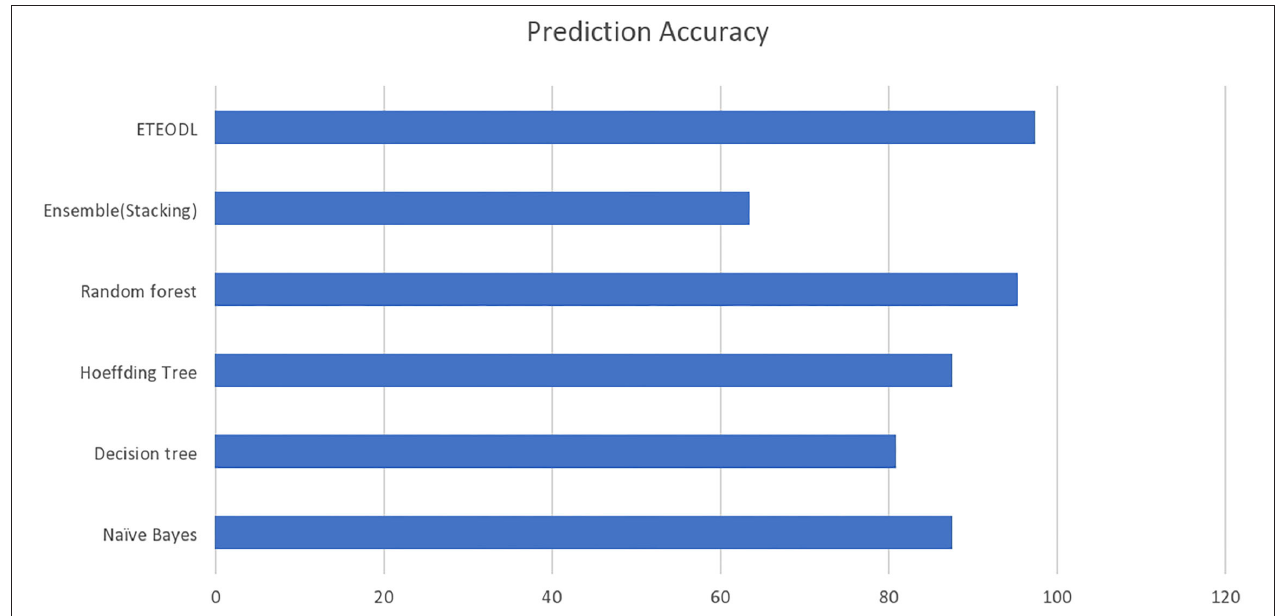
FIGURE 2 | Accuracy (%) comparison with existing methods.